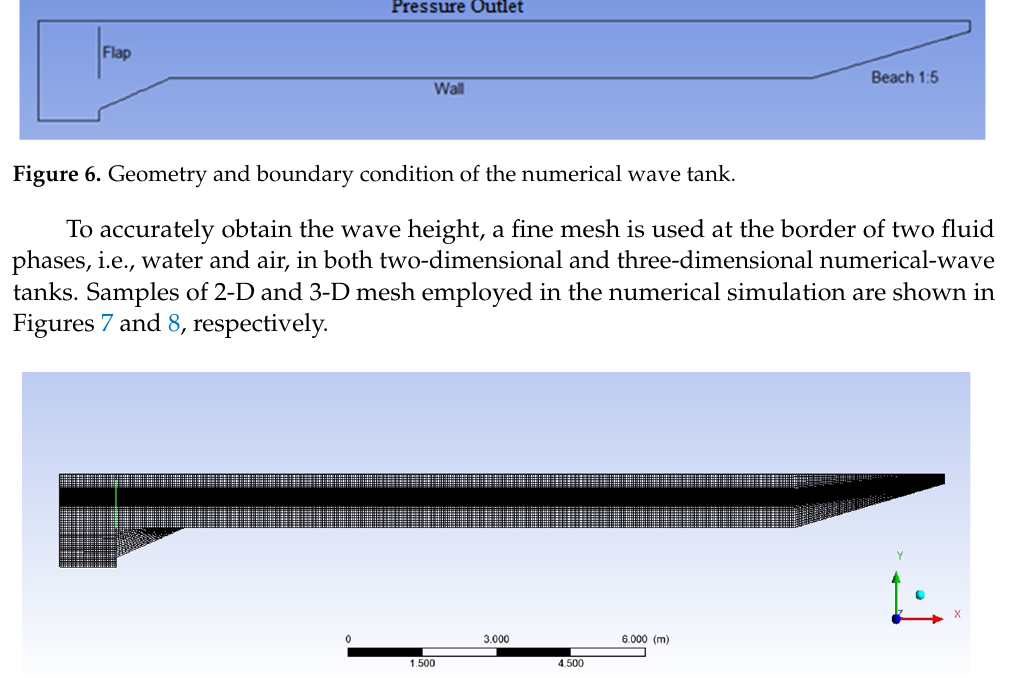
Figure 7. A sample mesh of the two-dimensional numerical wave tank.